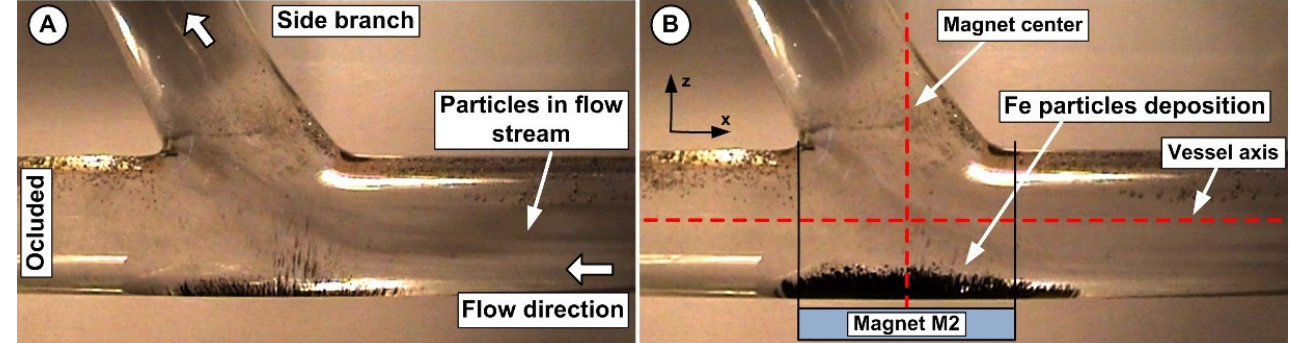
Figure 14. Fe particles deposit under the magnetic force generated by the permanent ferrite magnet having a grade of Y35 (magnet M2). Fe particles were injected for a period of 30 s. ( A ) Particle depositions over 5 s. ( B ) Depositions of particles at the end of the 30 s injection period. The magnet’s center in the z direction is in line with the vertical axis of the vessel bifurcation. The deposition shape shows how the drag force balances the magnetic force. Both investigations were conducted for identical working conditions, fluid velocity V f = 0.12 m/s, flow rate Q = 362 mL/min, Reynolds number of Re = 281, and distance between the vessel bottom wall and the magnet surface h = 5